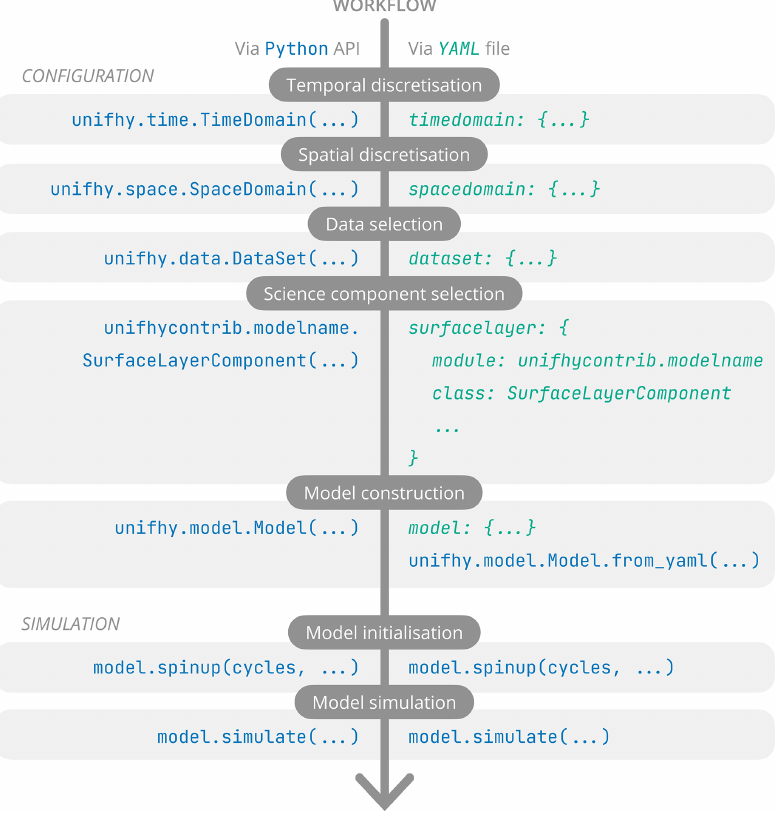
Figure 3. Workflow to follow to configure and use the modelling framework, exclusively via the Python API on the left-hand side, and via the use of a YAML file for configuration on the right-hand